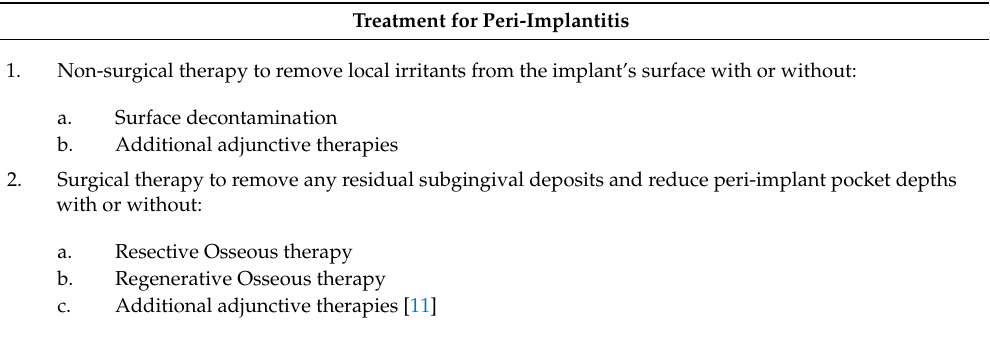
Table 1. Treatment for peri-implantitis